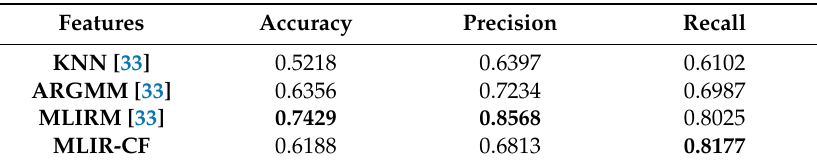
Table 5. Comparisons of multi-label RSIR methods. The bold values mean the best result for each performance